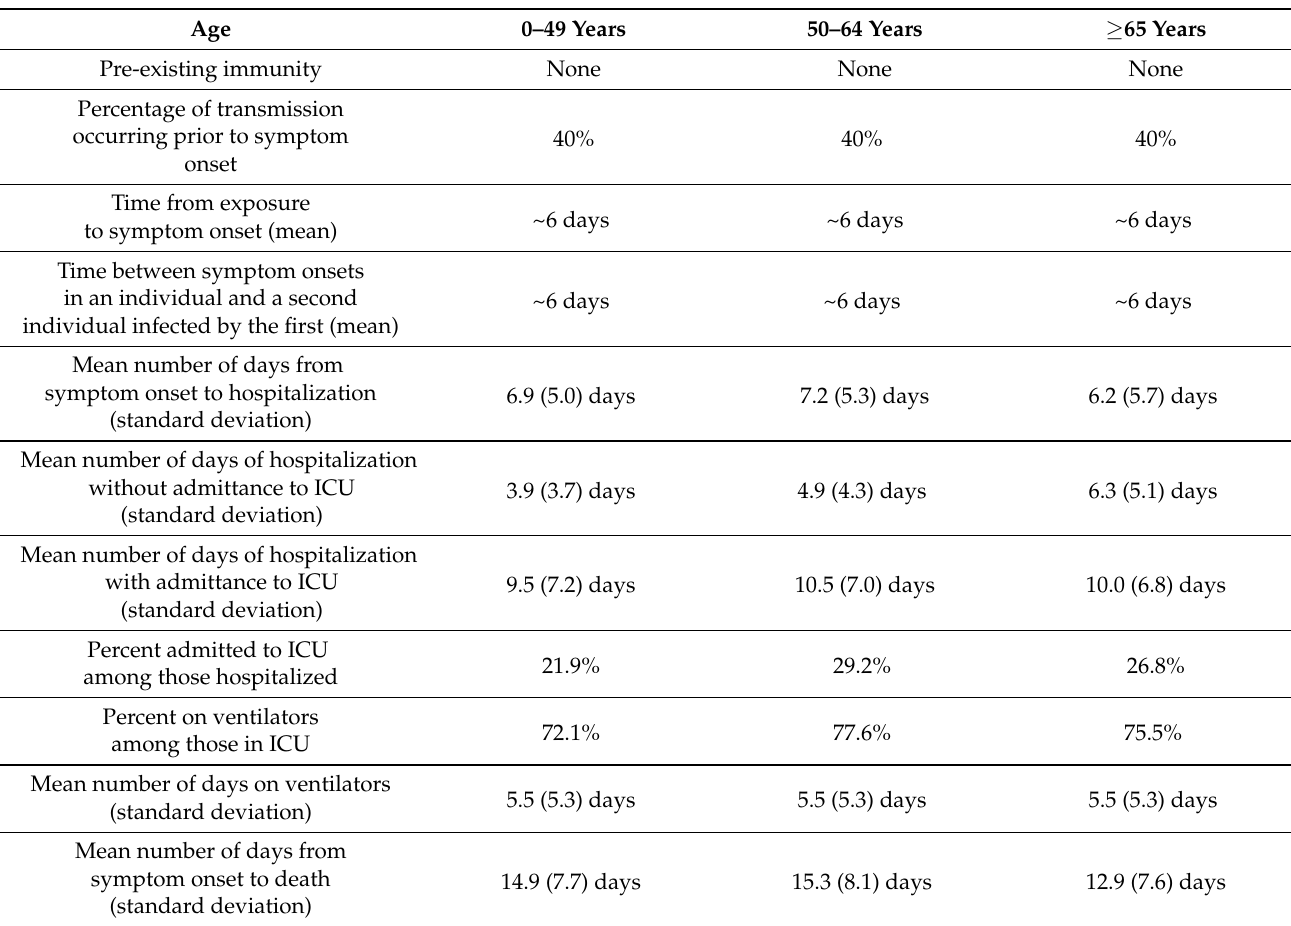
Table 2. Constant characteristic parameter values for COVID-19; source Khalili et al. (2020); Kucharski et al. (2020); Li et al. (2020); Linton et al. (2020); Russell et al. (2020); Salje et al. (2020); Verity et al. (2020); Woelfel et al. (2020).